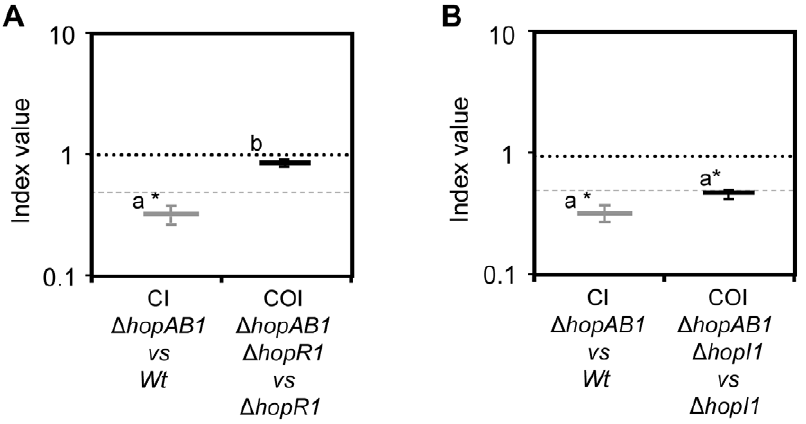
Figure 7. Cancelled-out index (COI) epistasis analysis of Pph 1448a effectors. Epistasis analysis of HopR1 (A) and HopI1 (B) on the contribution to virulence of HopAB1. Double mutants strains were co-infiltrated with each single mutant strain and the corresponding COI was determined at 7 dpi. All relevant CIs are included (grey) for comparison purposes. Each COI corresponds to the mean of at least three independent experiments with three replicates per experiment. A dashed line corresponding to an index value=0.5 is included for reference. Error bars represent the standard error. Asterisks indicate results significantly different from one, as established by Student’s t-test ( P , 0.05). Mean values marked with the same letter (a or b) indicate results not significantly different from each other, as established by One Way ANOVA and Holm-Sidak test for multiple comparisons ( P , 0.05).